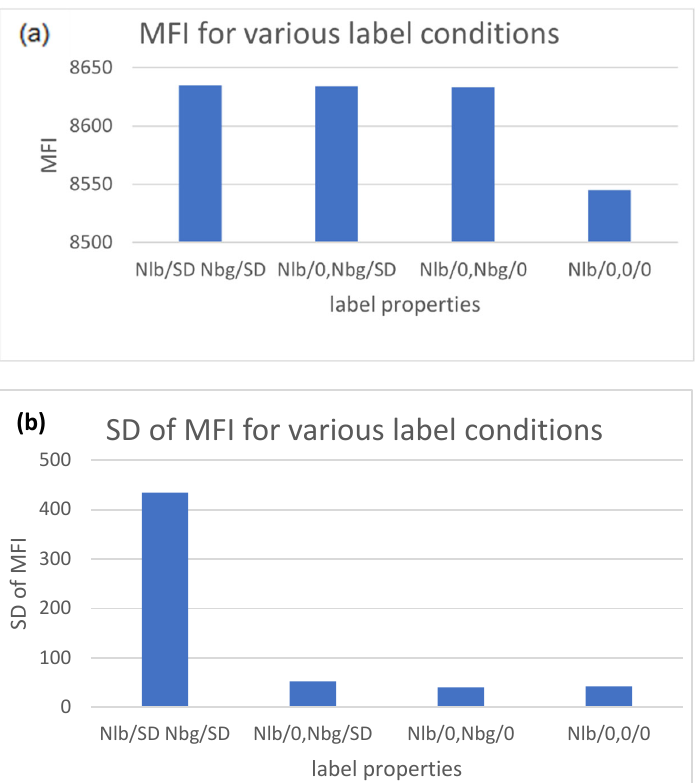
Figure 7. ( a ) Each bar gives the value of MFI from 128 independent calculations for bead M with label conditions specified at the bottom of the bar. A zero means that the specified value was set to 0 in the calculation. ( b ) Each bar gives the SD of the MFI value shown in ( a ) with the same label properties.